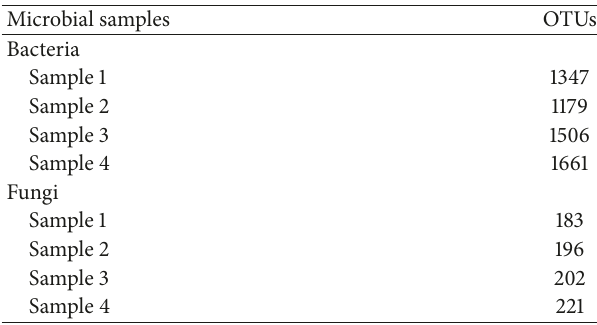
Table 1: Number of OTUs in the